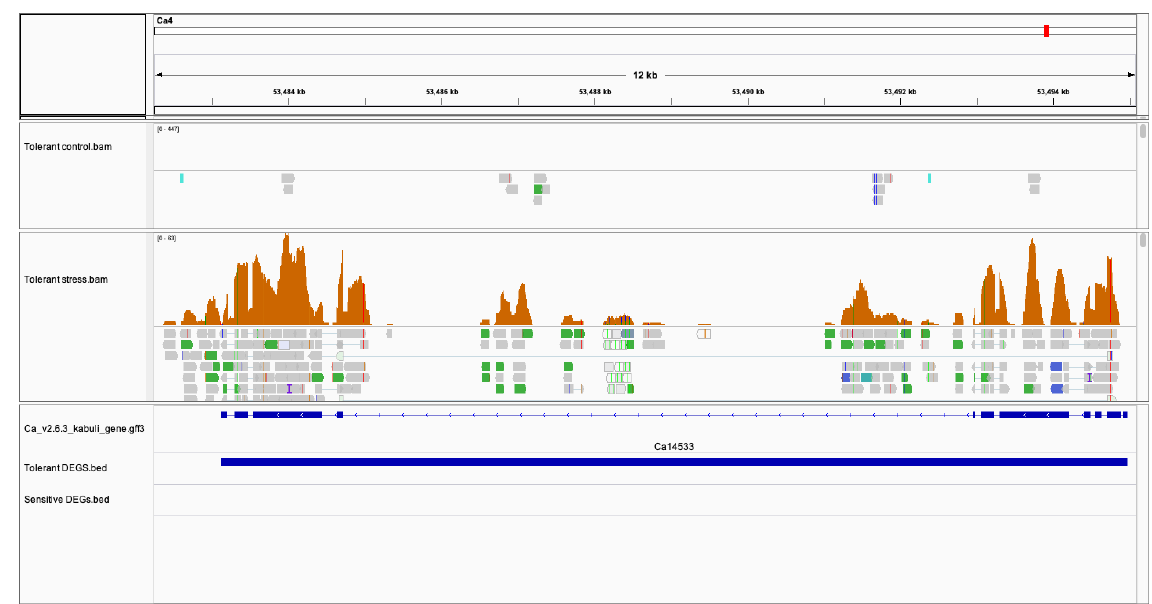
Figure 9. Integrative Genome Viewer (IGV) shows upregulation of ABORTED MICROSPORES ( AMS ) (Ca14533) gene in tolerant genotype as compared to sensitive genotype in response to salt stress. The tracks include CDC frontier Kabuli v2.6.3 reference fasta; annotated gene. gff3; accepted.hits.bam from tolerant control and control stress and differentially expressed gene coordinates.